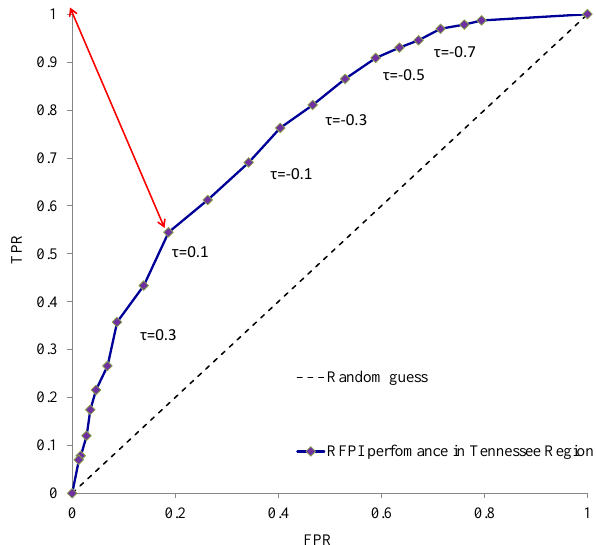
Figure 4. An example showing the ROC curve estimated for the Tennessee watershed using different RFPI thresholds. The optimal value of the classifier threshold τ for this watershed is 0.1, corre- sponding to the point on the ROC curve that is the closest to the (0; 1) point. The dashed line represents random guess, which has an area under the curve (AUC) of 0.5, whereas a predictive index such as RFPI has an AUC>0.5.